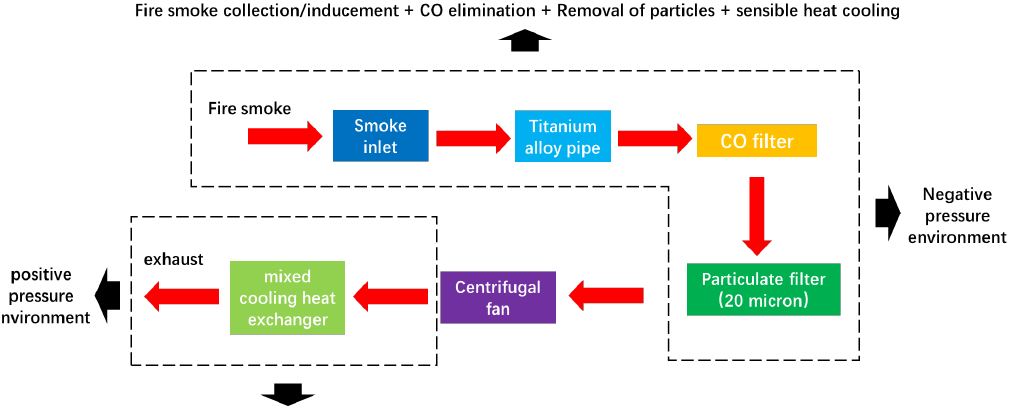
Figure 1. Fire smoke decontamination process.